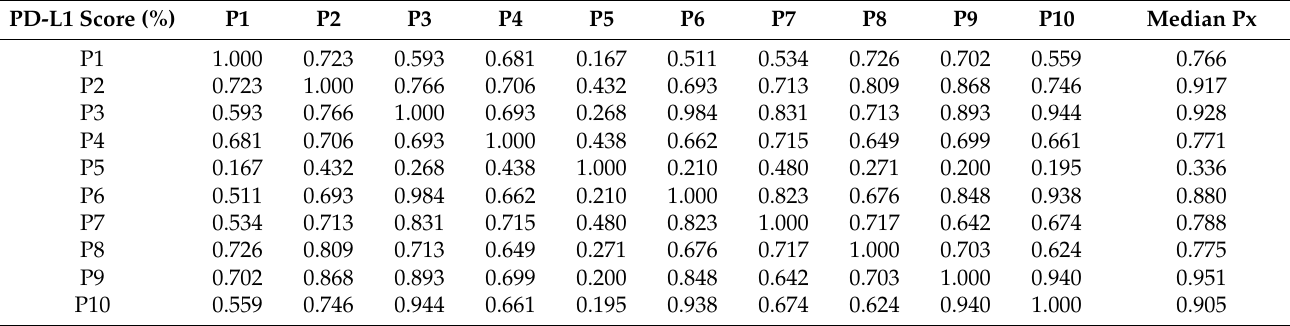
Table 2. Intraclass correlation coefficients for PD-L1/SP142 assessment as percentages in the study set, as evaluated by ten participating pathologists. Because an ad hoc consensus score was lacking, the median Px PD-L1 score was used as a surrogate consensus